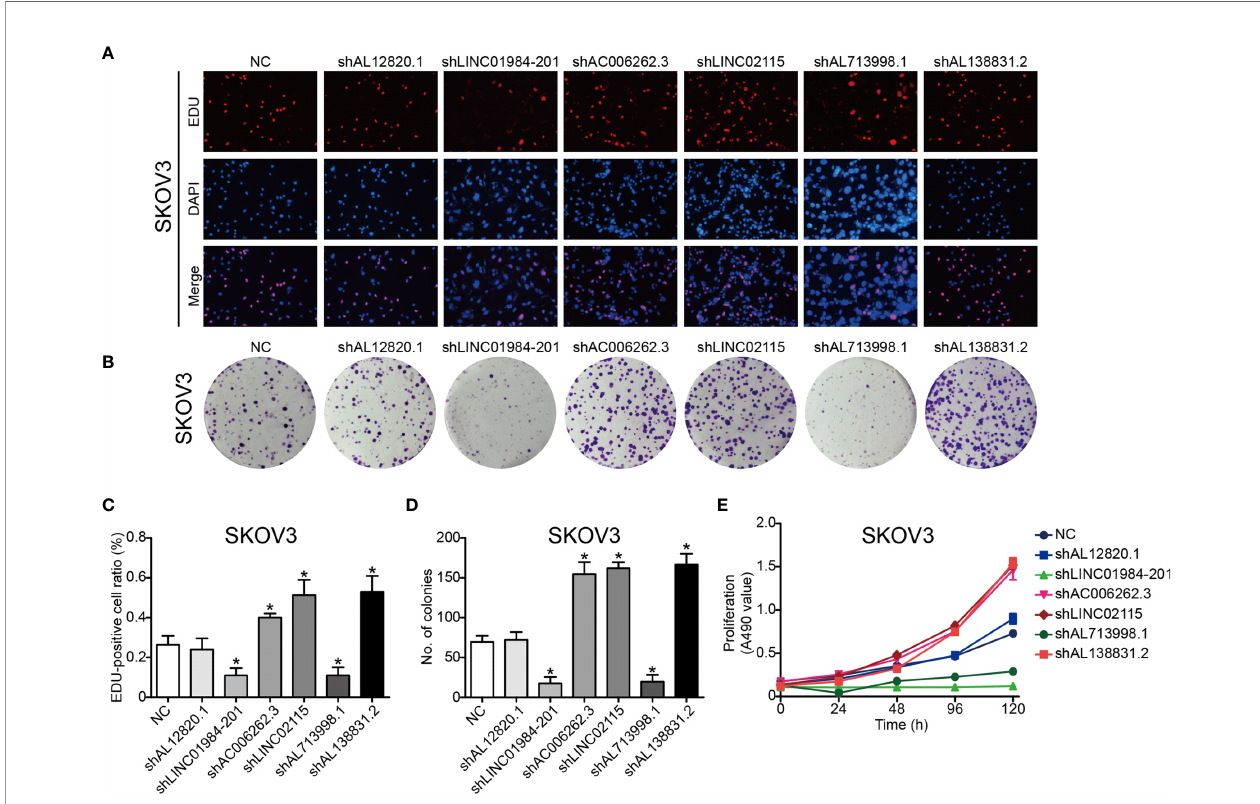
FIGURE 5 | LncRNAs regulated the proliferation ability of SKOV3 cancer cell line. After knocking down of the LncRNAs, the proliferation ability of SKOV3 cancer cells was detected by Edu staining, colony formation and CCK8 assay. (A) Representative images of EDU staining; (B) Representative images of colony formation; (C) The quanti fi cation result of EDU staining; (D) The quanti fi cation result of colony formation; (E) The cell viability inspected by CCK8 assay. P*<0.05 vs . NC. Data were from three independent